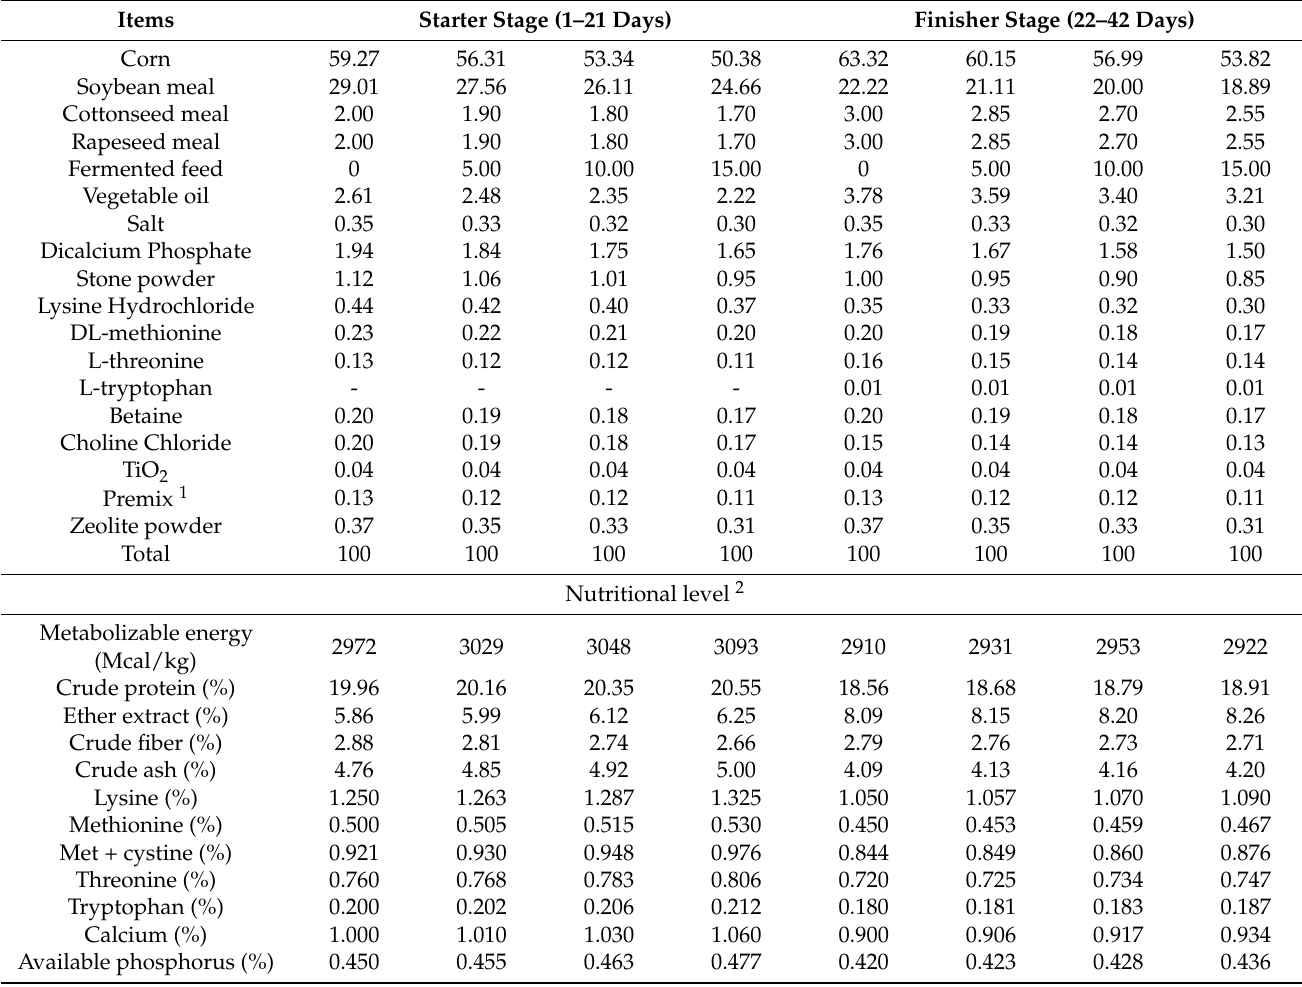
Table 1. Basic diet composition and nutritional content (air-dried basis)